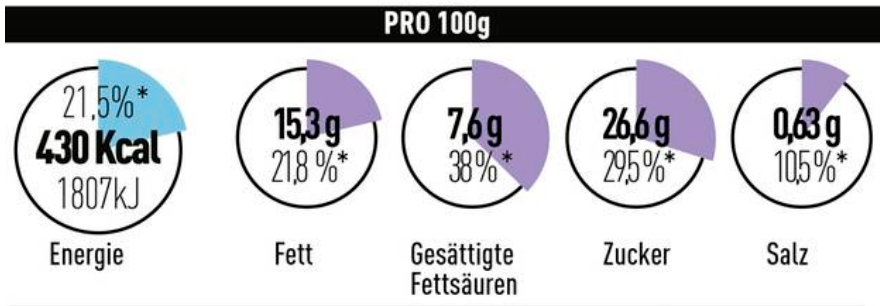
Figure A12. Nutritional Circles (Germany) provides the energy content in both kilojoules and kilocalories and the content of four nutrients (fat, saturated fat, sugar and salt) in grams and as a percentage of daily reference intake per 100 g or 100 mL. In complement, pie charts represent the amount of energy and nutrients in proportion to the recommended daily amount for an average adult. This scheme is supported by the industry association Federation for Food Law and Food Science (BLL).